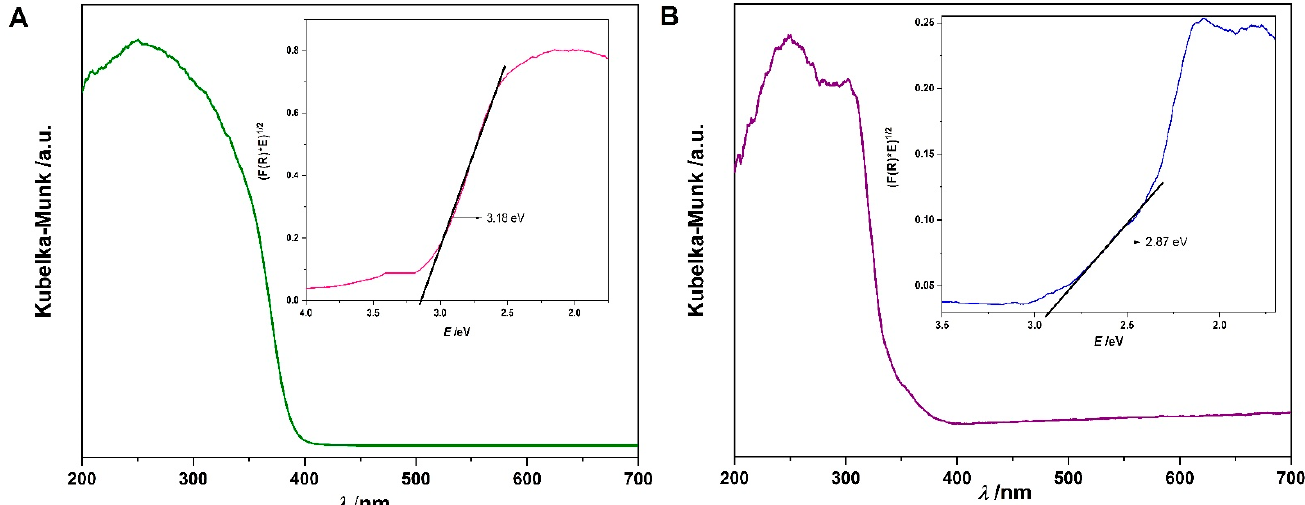
Figure 3. Diffuse reflectance UV-Vis spectra of ( A ) pure TiO 2 and ( B ) rGO/TiO 2 nanocomposite. Insets are corresponding plots of transformed Kubelka–Munk function versus the energy of the light for as-prepared photocatalysts.